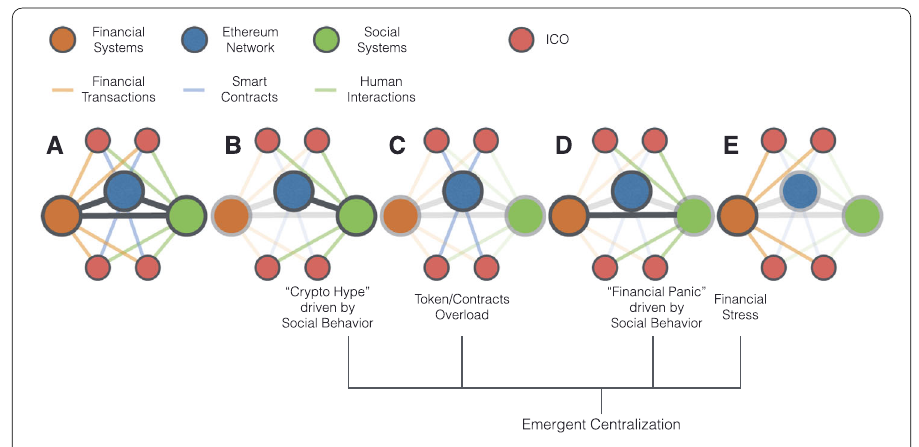
Figure 3 Emergent centralization. ( A ) The ecosystem of socio-technical systems involving the Ethereum network, online social networks and financial systems (e.g., exchanges). ( B ) Social networks drive the hype about ICOs. ( C ) The Ethereum network is overloaded by investors and the system slows down. ( D ) Fear for a (supposed) crash generates a financial panic leading to a ( E ) stress of financial systems where, eventually, failures are